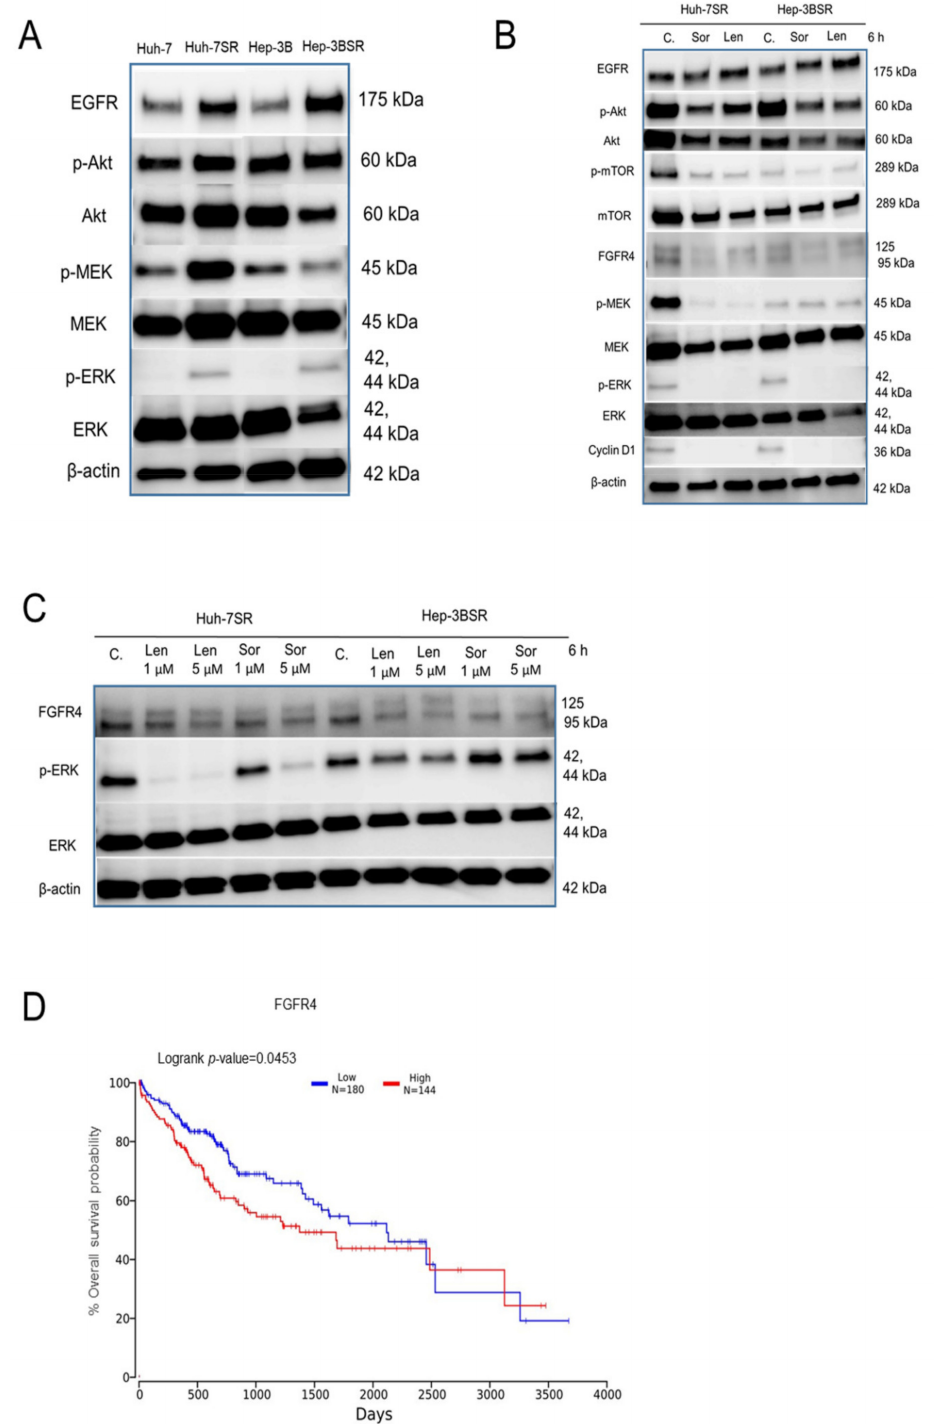
Figure 4. The underlying mechanisms of lenvatinib in sorafenib-resistant HCC cells may be through the FGFR4-ERK signaling pathway. ( A ) Proteins expressed in wild-type and sorafenib-resistant HCC cells. ( B ) Huh-7SR and Hep-3BSR cells were treated with 10 µ M sorafenib or lenvatinib for 6 h. Protein expression was analyzed using Western blot. ( C ) Huh-7SR and Hep-3BSR cells were treated with 1 and 5 µ M sorafenib or lenvatinib for 6 h, and the levels of FGFR4, p-ERK, and ERK were analyzed using Western blot. C.: control; Sor: sorafenib; Len: lenvatinib. ( D ) A lower FGFR4 level is associated with longer overall survival of HCC patients based on TCGA database analysis (http://www.oncolnc.org, accessed on 5 October